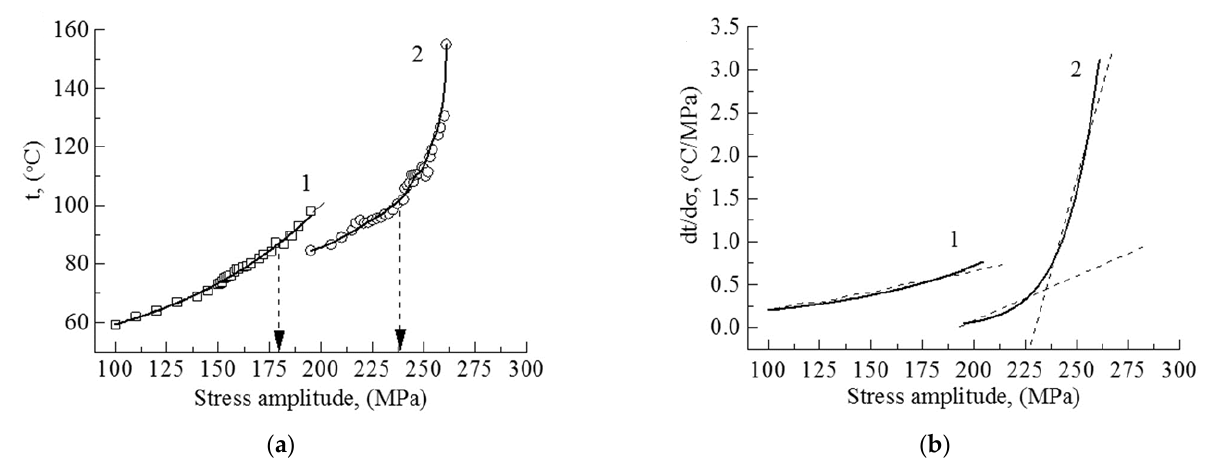
Figure 7. ( a ) The maximal temperature and ( b ) the rate of increasing the maximal temperature on the surface of CG (1) and UFG (2) Ti-45Nb alloys, a function of stress under cyclic loading.